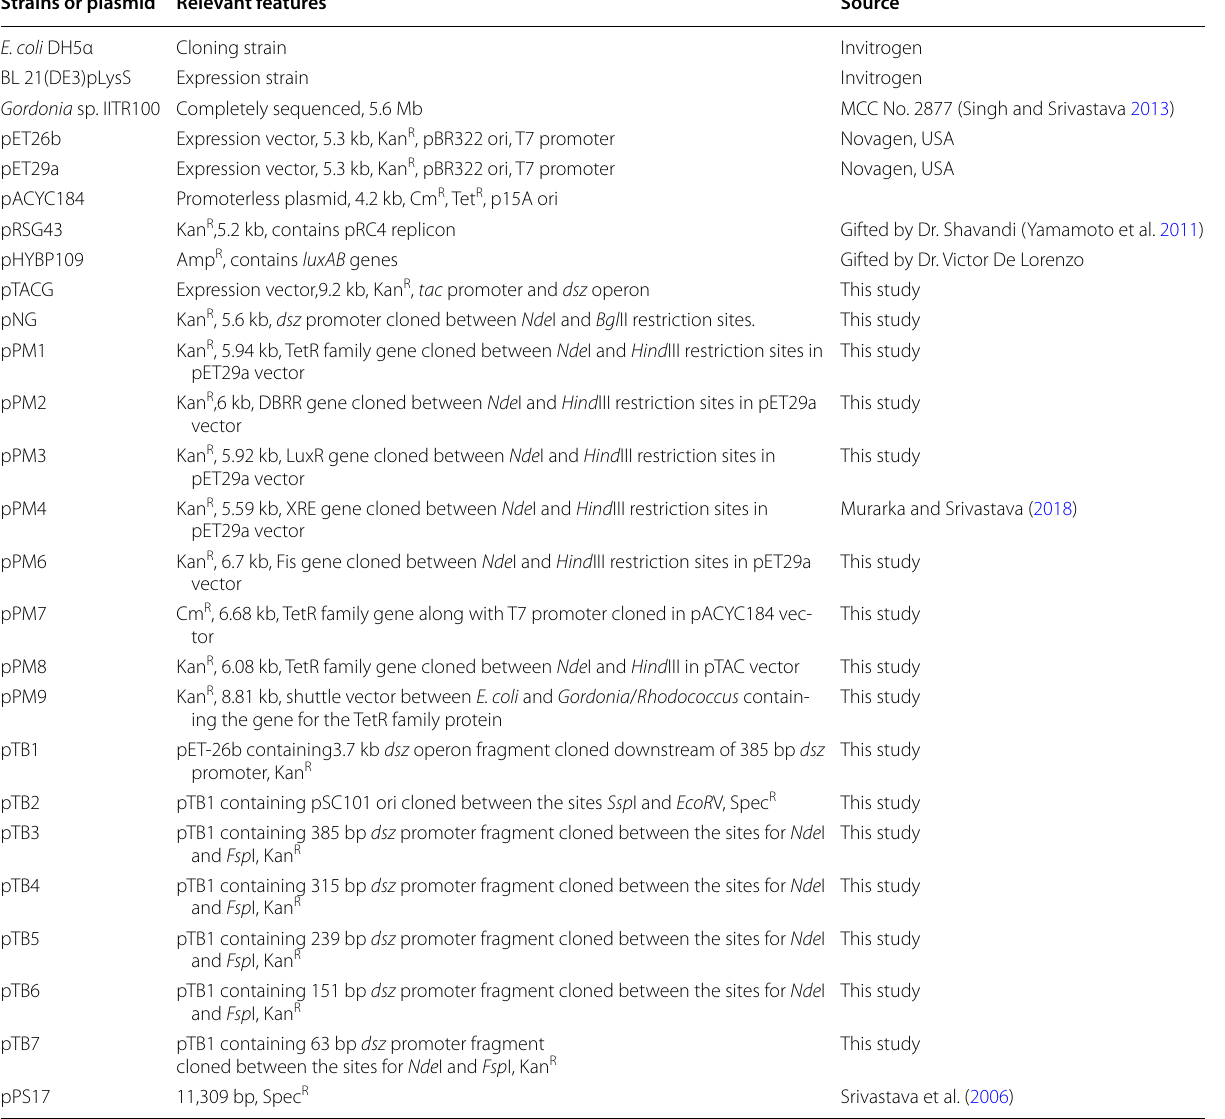
Table 1 Strains and plasmids used in this study Strains or plasmid Relevant